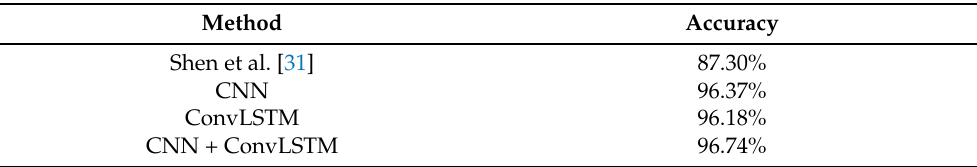
Table 2. Multi-way user classification accuracy rates on the HMOG data set, obtained by a baseline model based on handcrafted features versus our CNN and ConvLSTM models and their combination represented by an ensemble that merges the two